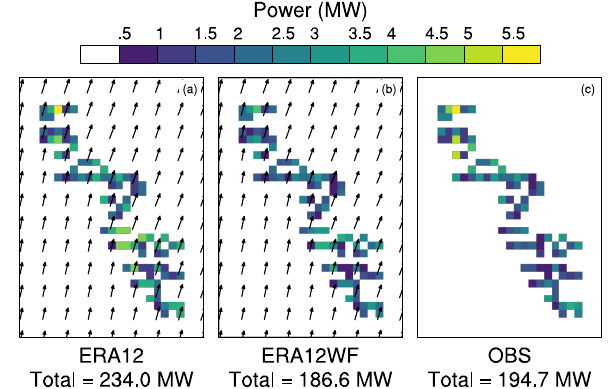
Figure 5. The power production for one 10min period from the ERA12 estimates (a) , the ERA12WF outputs (b) , and the observa- tion (abbreviated as OBS) (c) . The total power in each grid cell is presented regardless of the number of turbines in each cell, and the wind-farm totals are summarized at the bottom. The vectors indicate the simulated winds, and their lengths correspond to the horizontal velocity